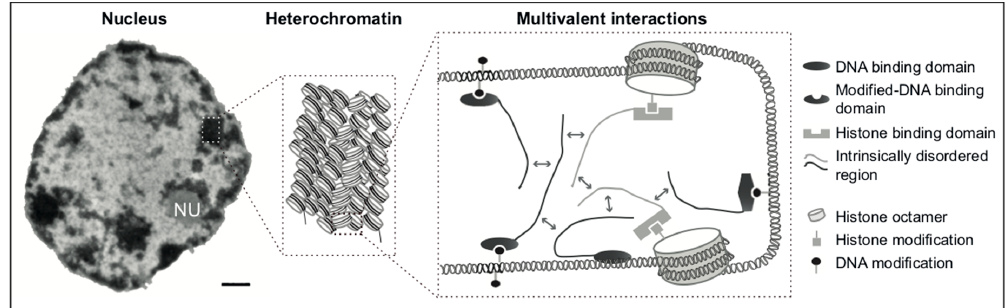
Figure 3. Role of multivalent interactions in heterochromatin formation. Left: transmission electron microscopy image of a mouse liver cell nucleus at interphase with electron dense regions corresponding to heterochromatin and electron light regions corresponding to euchromatin. NU: nucleoli. Scale bar = 0.5 µm. Middle: graphical representation of heterochromatin. Nucleosomes are tightly packed within heterochromatin and show limited accessibility to multiple factors binding DNA. Right: cartoon showing multivalent interactions that promote heterochromatin formation. Chromatin compaction can be maintained by multivalent interactions involving DNA and multiple proteins. Unmethylated, methylated DNA and posttranslational modifications of histones could recruit multiple protein factors containing intrinsically disordered regions (IDR) (like MeCP2 and HP1). Via these IDR regions multivalent homo and hetero weak interactions take place, promoting the formation of heterochromatin possibly by phase separation.